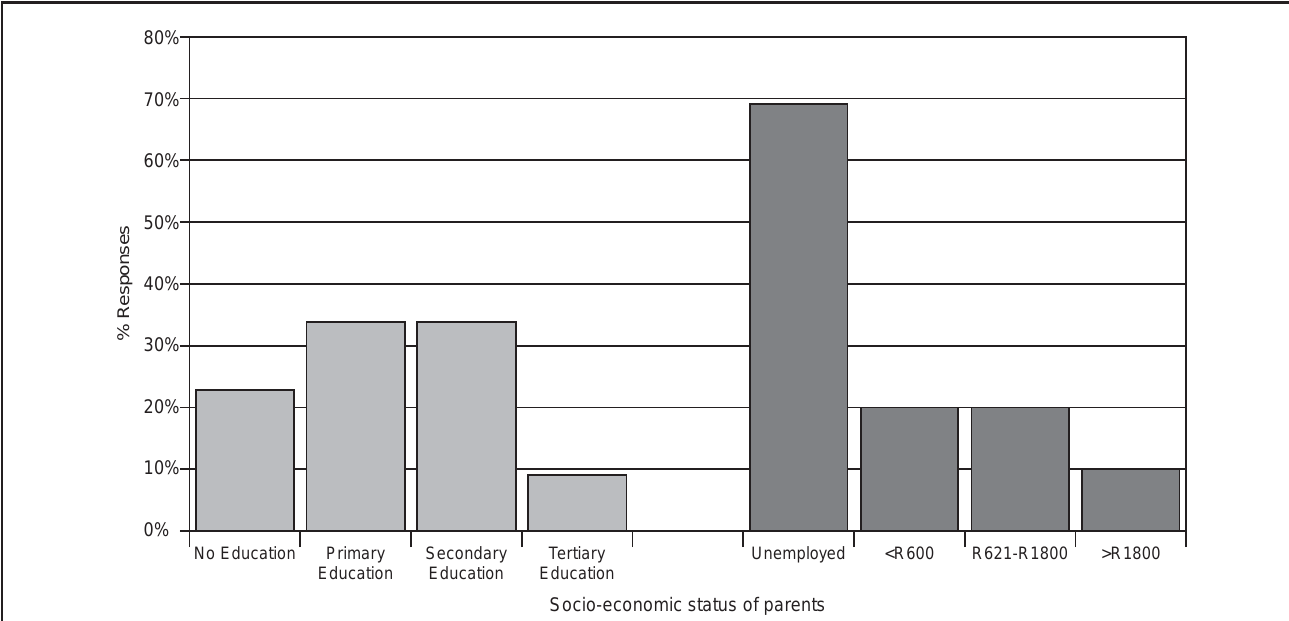
Figure 1: Socio-economic status of parents